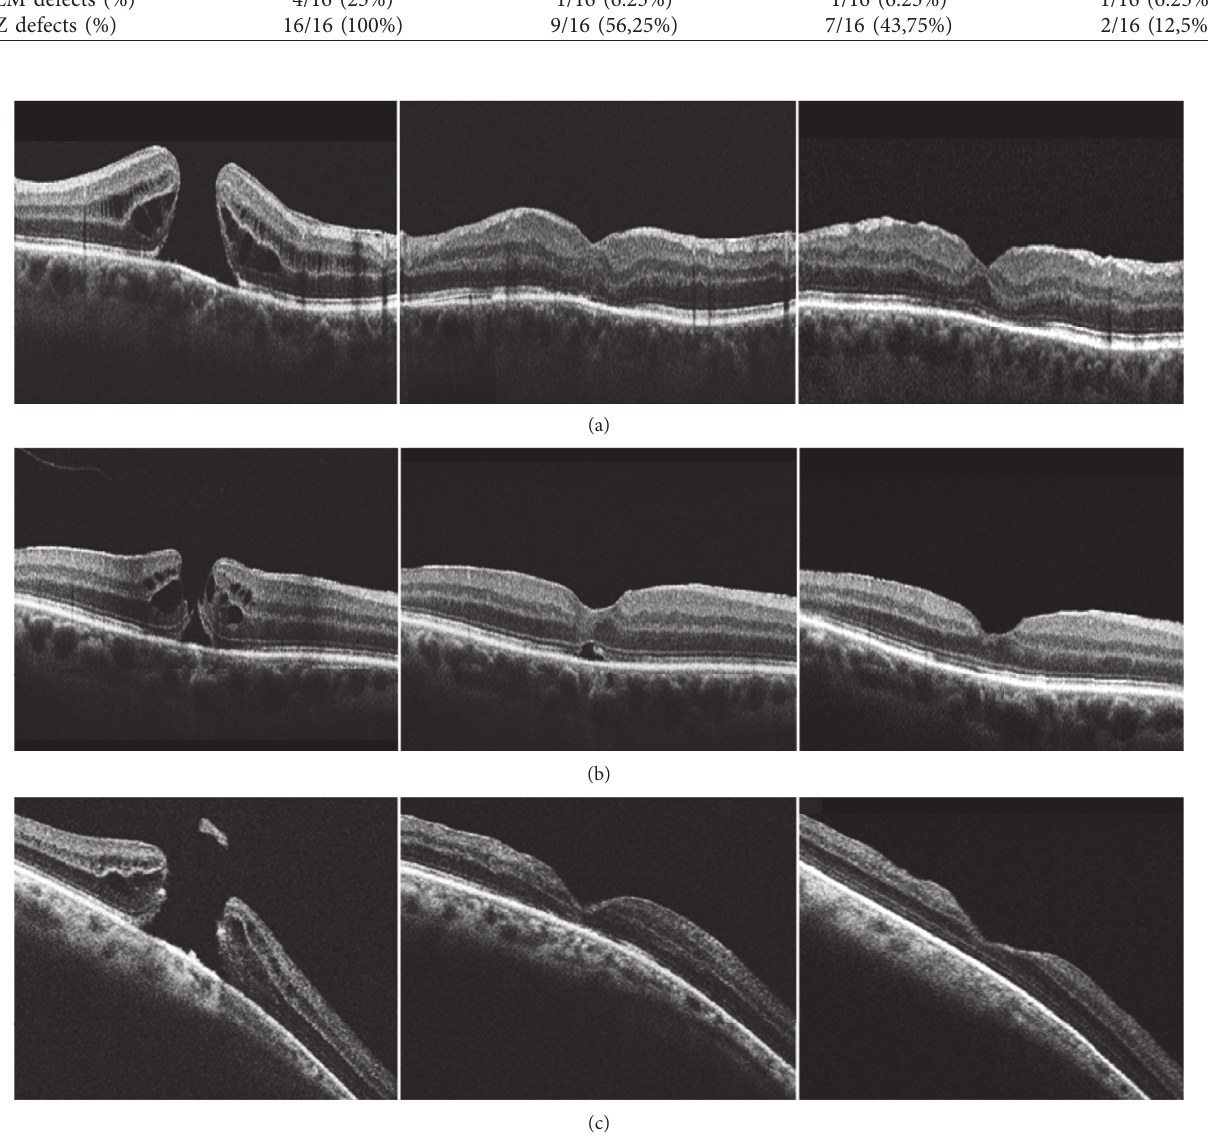
Figure 1: Baseline (left), 1-month (middle), and 6-month (right) follow-up SD-OCTimages from three patients (a), (b), and (c) with FTMH and undergoing the inverted ILM flap technique. At the 6-month follow-up visit, the EZ reconstitution was